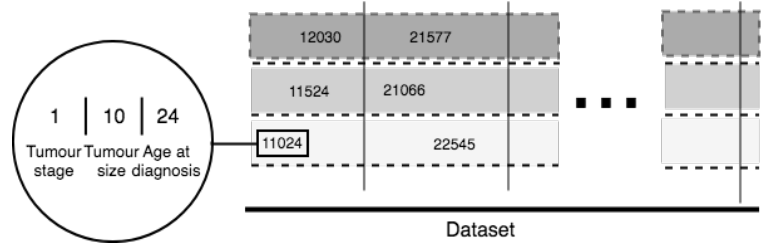
Figure 3. TICF complex